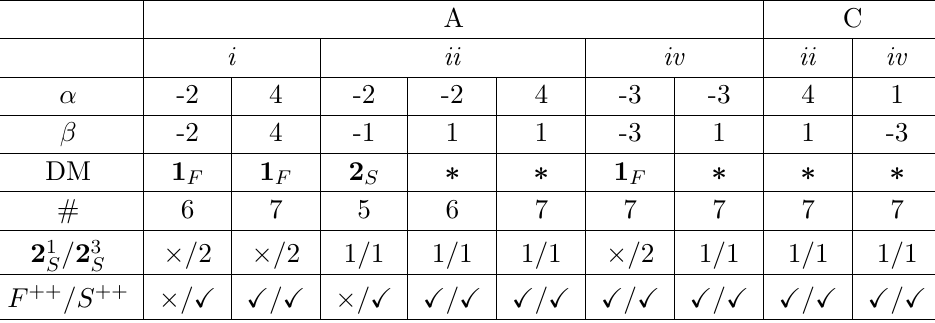
Table 7. The same as in table 2 for Class 1.f of (cid:12)gure